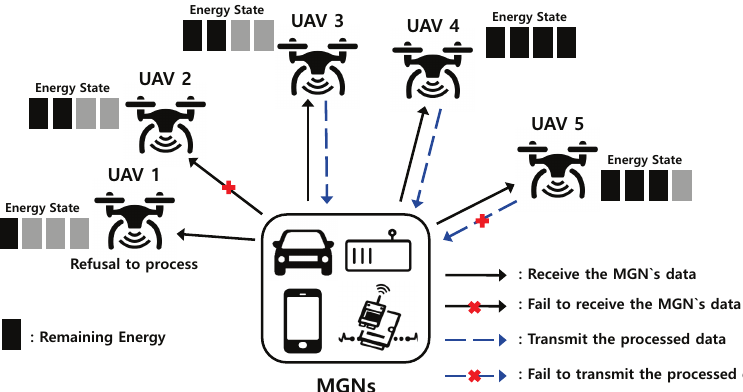
Figure 1. Example of a UAV-based edge computing system